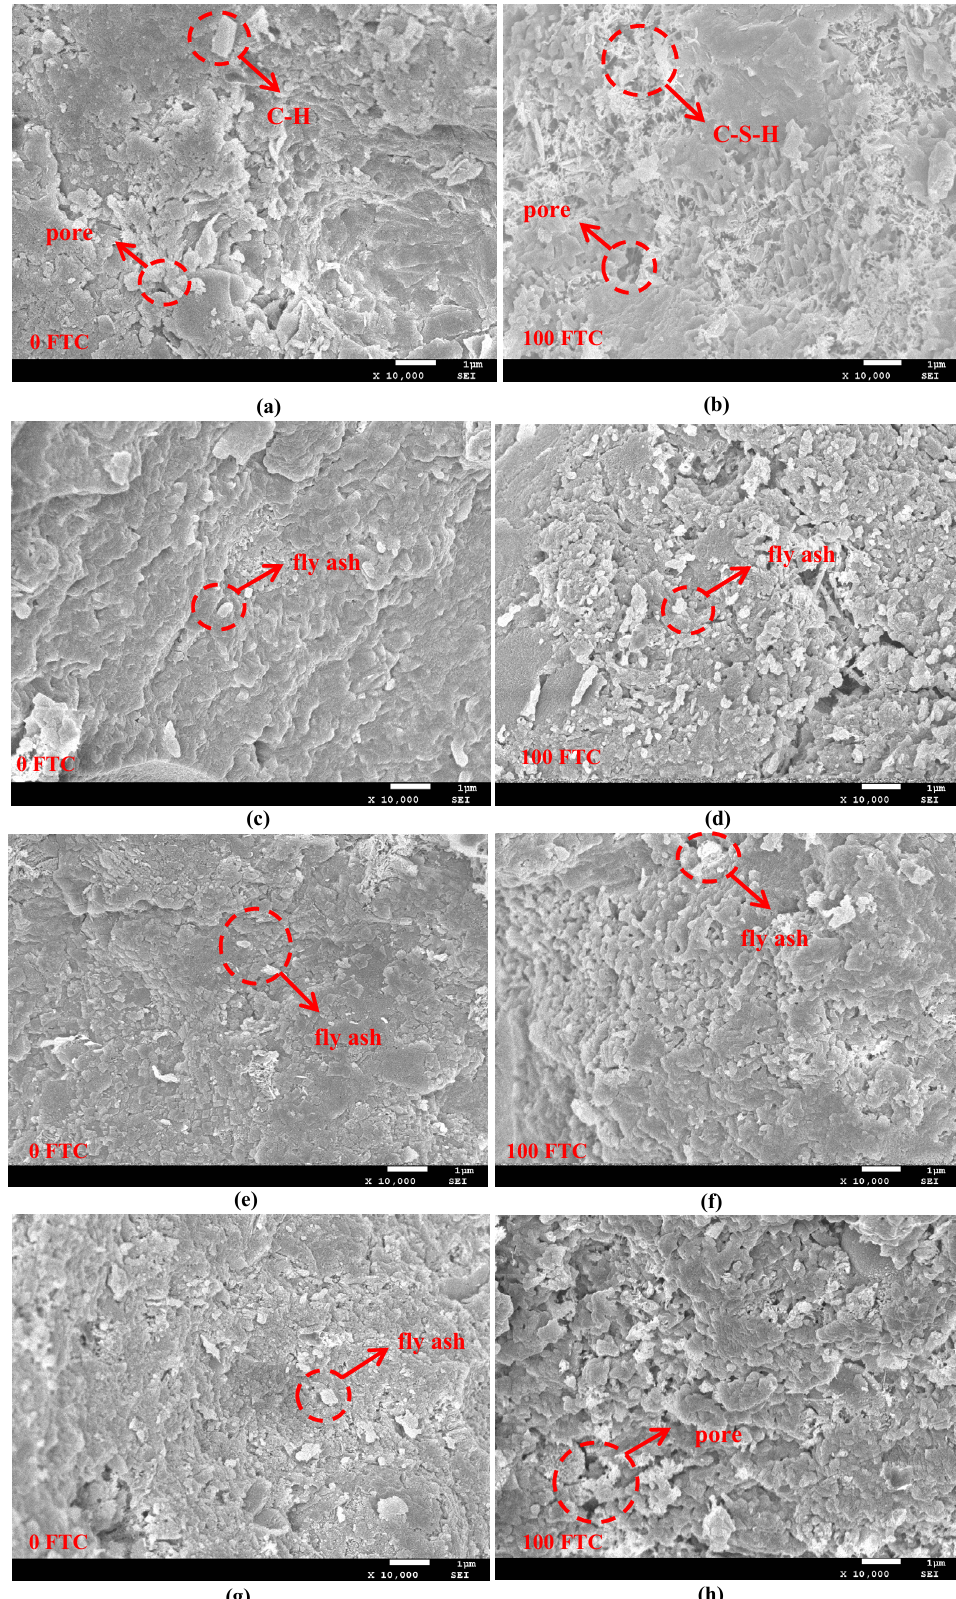
Figure 7. Microstructure of concrete in different solutions after 0 and 100 FTCs: ( a ) 0 FA for 0 FTCs, ( b ) 0 FA for 1000 FTCs, ( c ) 10% FA for 0 FTCs, ( d ) 10%0 FA for 100 FTCs, ( e ) 20% FA for 0 FTCs, ( f ) 20% FA for 100 FTCs, ( g ) 30% FA for 0 FTCs, ( h ) 30% FA for 100